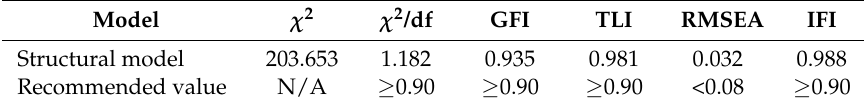
Table 5. Summary of Goodness-of Fit Indices for the Structural Models.